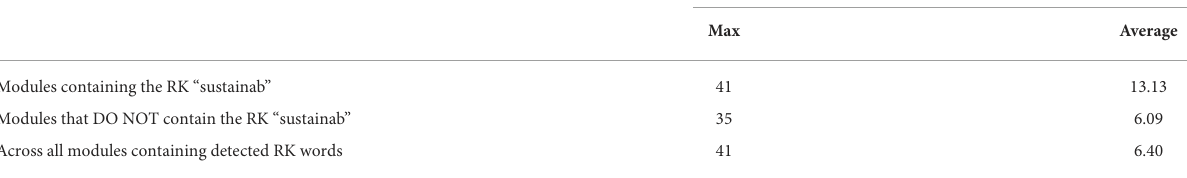
TABLE 6 Number of RKs for modules containing or absent of the “sustainab”